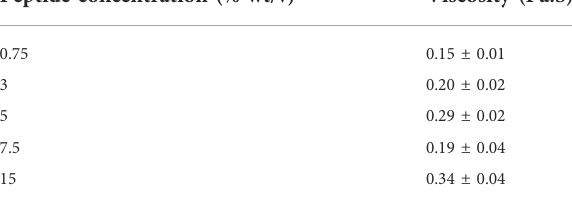
TABLE 1 Viscosity measurement of peptide solutions in 80:20 (v/v) acetic acid in water using CAP 2000 + Viscosimeter (AMETEK Brook fi eld) following manufacturer instructions.